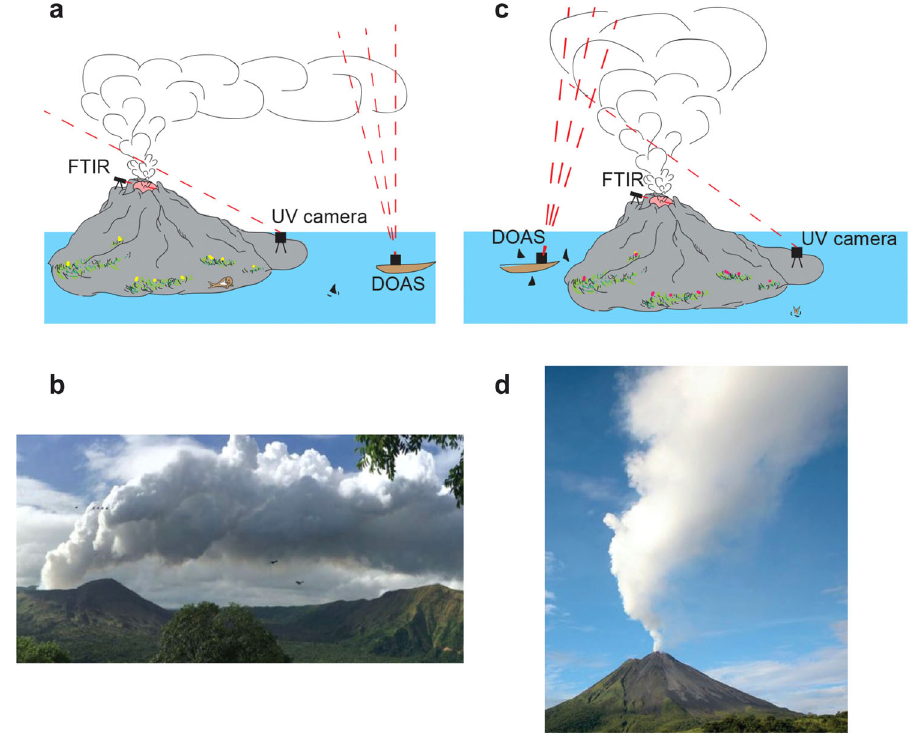
Fig. 1 Volcanic plumes. The methods by which volcanic gases are typically measured include Fourier transform infrared spectroscopy (FTIR), Ultraviolet camera (UV camera) and Differential Optical Absorption Spectroscopy (DOAS). a Measurements in case of a wind-blown plume such as b the one observed at Masaya Volcano in Nicaragua. c Measurements in case of a vertical plume such as d the one observed at Arenal Volcano in Costa Rica. Photocredit: b obtained from vumo.cloud; d obtained from